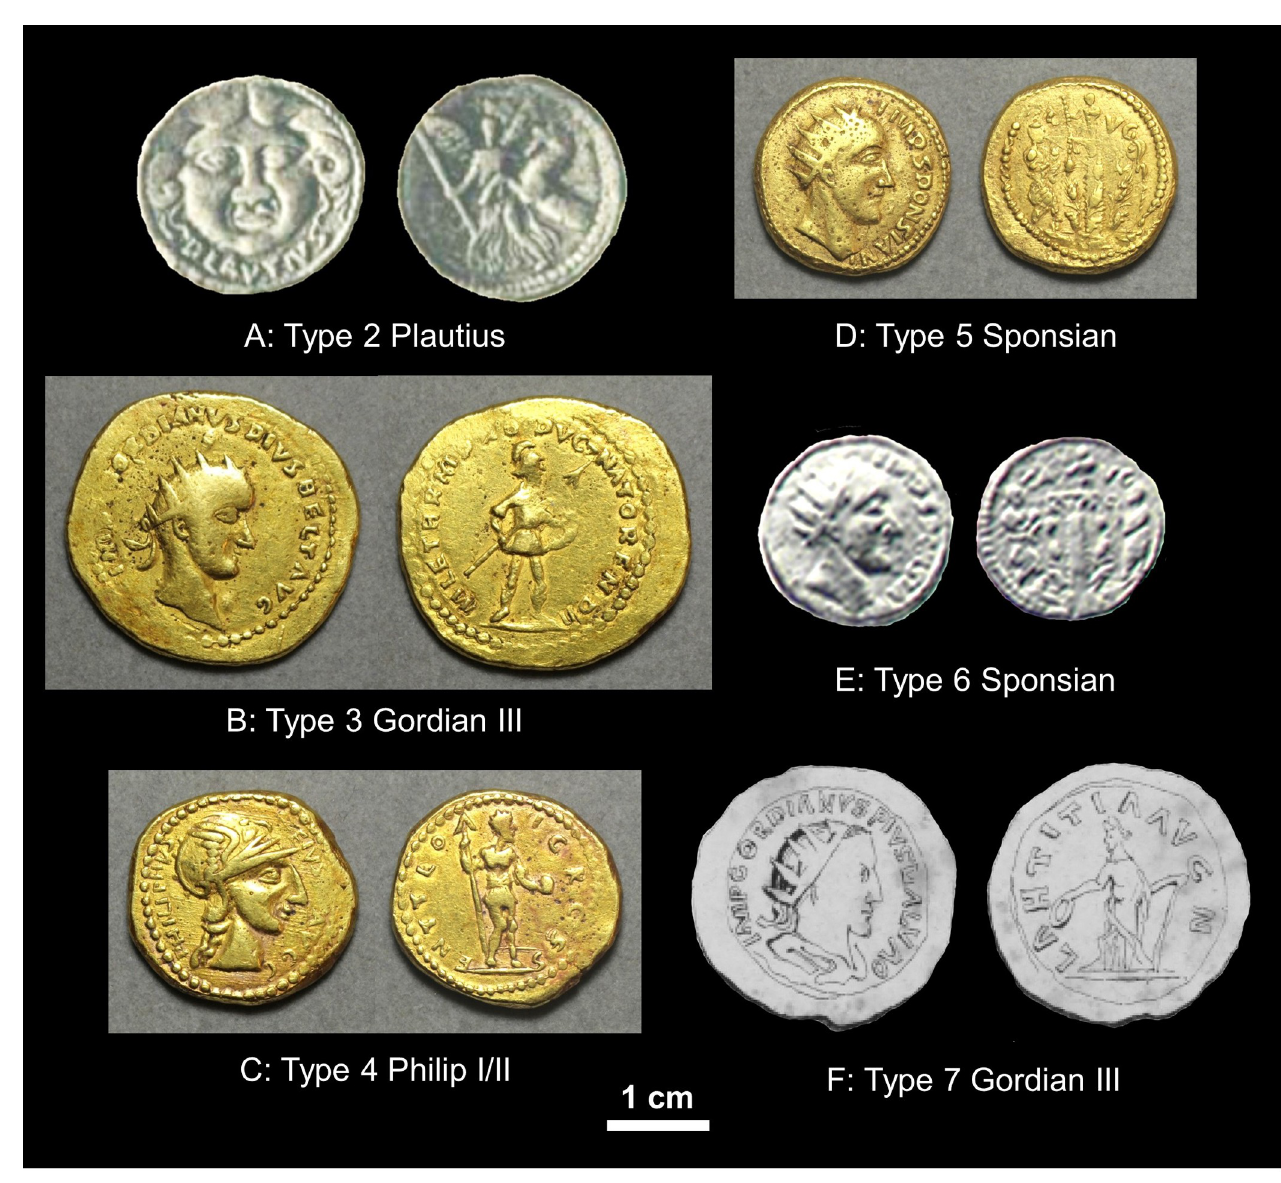
Fig 2. Coins of the wider assemblage, and their typology. Note that no image exists of the lost Type 1 of Alexander the Great. A) Type 2 of Plautius, Specimen 2.4 in Table 1, greyscale photograph reproduced from Ref. [3], scale approximate; B) Type 3 of Gordian III, Specimen 3.2 in Table 1, GLAHM:29596, photographed for this study; C) Type 4 of Philip I or Philip II, Specimen 4.4 in Table 1, GLAHM:29820, photographed for this study; D) Type 5 of Sponsian, Specimen 5.3 in Table 1, GLAHM:40333, photographed for this study (same as Fig 1); E) Type 6 of Sponsian, Specimen 6.1 in Table 1, greyscale photograph reproduced from Ref. [28], scale approximate; F) Type 7 of Gordian III, Specimen 7.1 in Table 1, greyscale line drawing reproduced from Ref. [29], scale